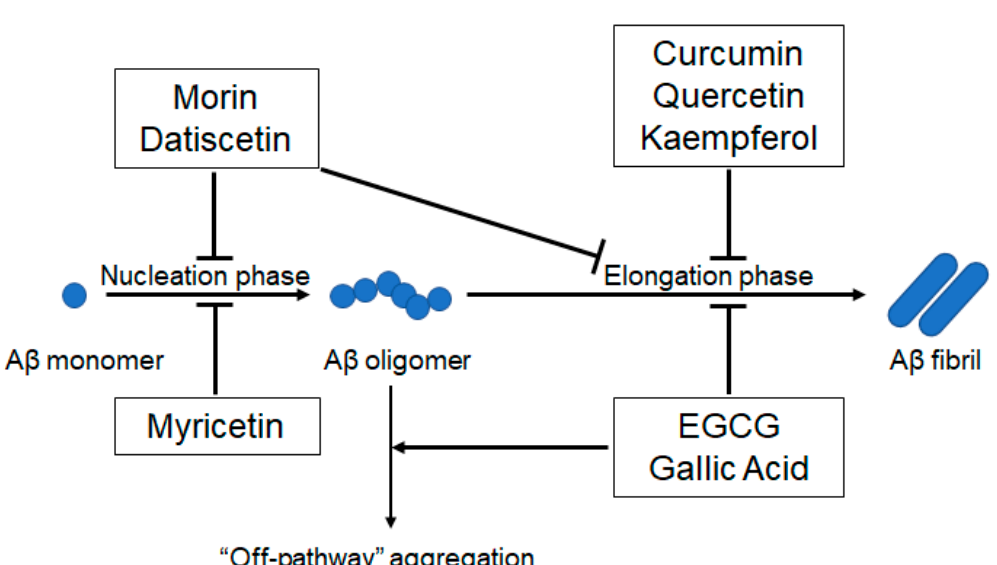
Figure 1. A schematic model showing the inhibitory effects of polyphenols on A β aggregation, based on the “amyloid cascade hypothesis.” Myricetin inhibits nucleation [8]. Morin and datiscetin inhibit nucleation and elongation [9]. Curcumin [10], quercetin [11], and kaempferol [9] inhibit elongation. EGCG [12] and gallic acid [13] inhibit elongation and redirect A β oligomers to “off-pathway” aggregation. A β : amyloid β , EGCG: epigallocatechin gallate.